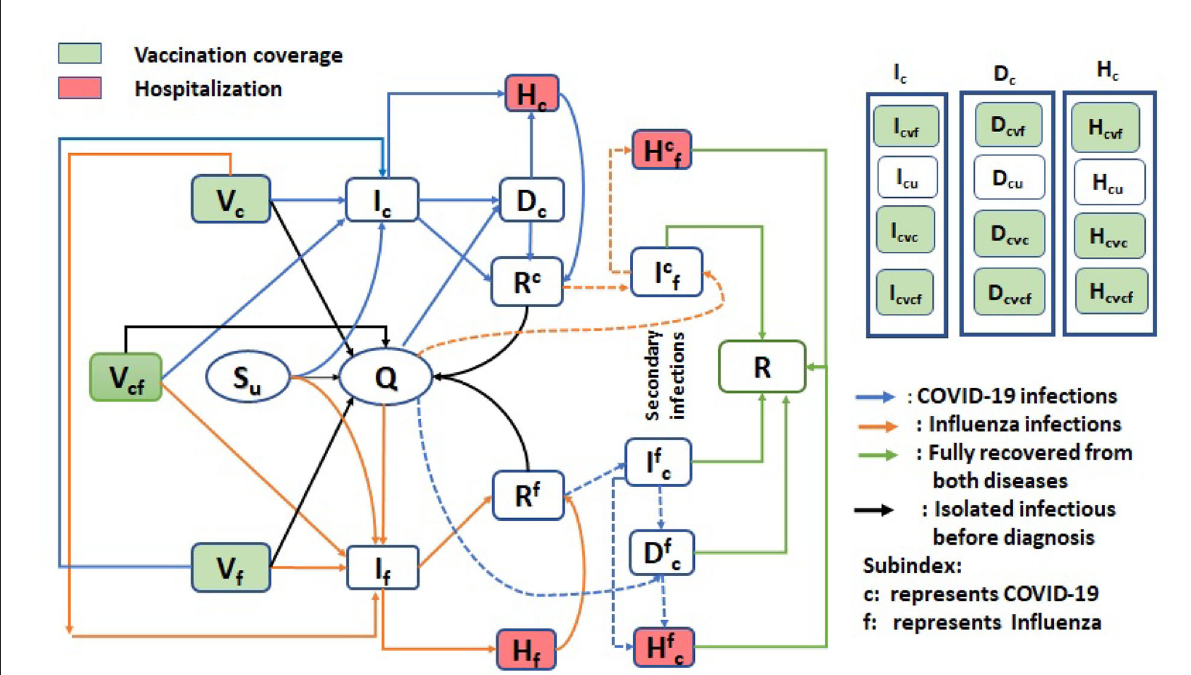
FIGURE1 A flow diagram of the transmission dynamics model, considering the co-circulation of influenza and SARS-CoV-2 viruses. On the right side of the diagram, classes I c , D c , and H c represent that there are further sub-classes in each of these compartments. Similarly, flu classes have sub